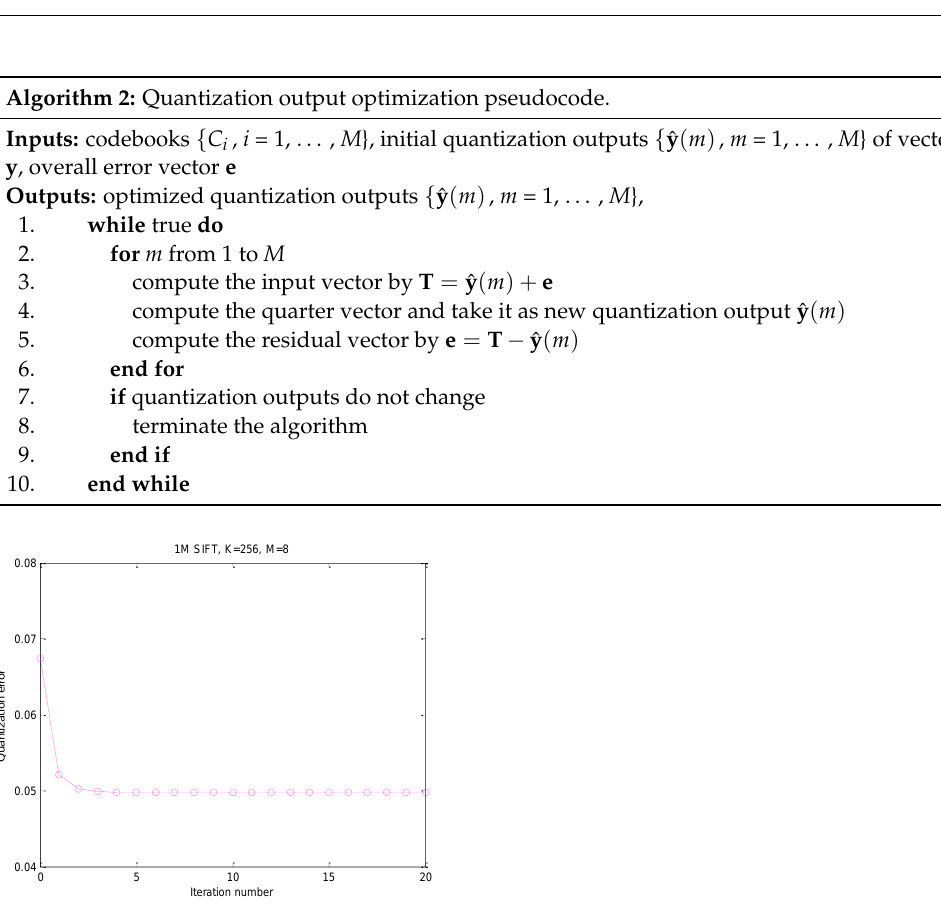
Figure 2. The convergence of quantization output optimization on a representative dataset of 1M SIFT database vectors with 8 codebooks, each codebook containing 256 centroids.